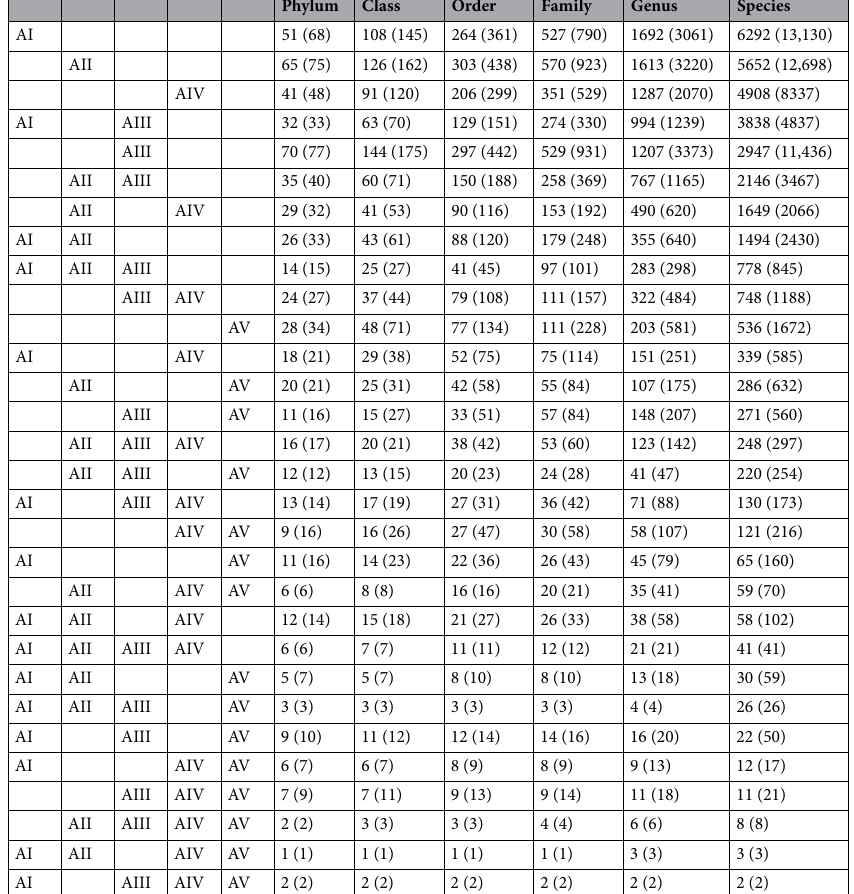
Table 1. Co-occurrence of five l-asparaginase types in the genomes of 32,940 bacterial species. The table rows show the exact combination of the different l-asparaginase types and information on the number of taxonomic units in which the combination occurs. Numbers in parentheses indicate taxonomic units with at least all types in each combination. Combinations of l-asparaginases are ordered according to the decreasing number of